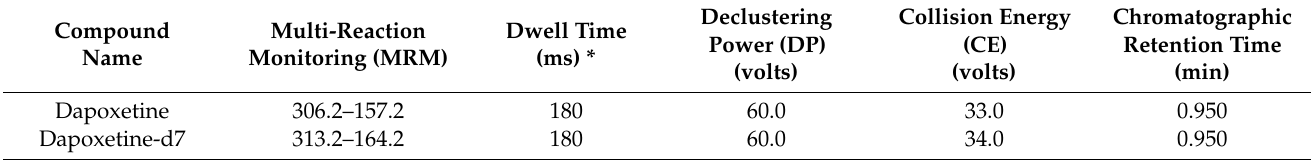
Table 7. The optimized mass spectrometric